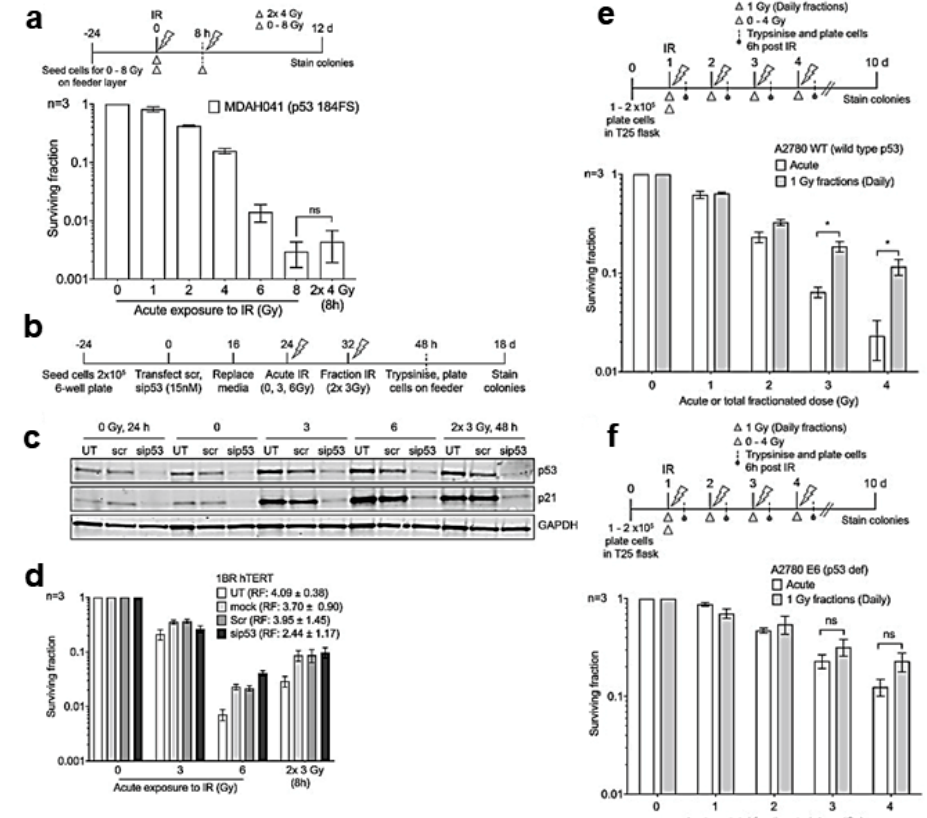
Figure 4. p53 modulates RT fraction size sensitivity in normal and malignant cells. ( a – d ). Split-dose recovery is not observed in primary fibroblast with loss of functional p53. ( a – d ). Transformed Li-Fraumeni fibroblasts MDAH041 were exposed to either acute or split-dose IR with indicated doses. ( a ) Colony survival assay confirms loss of split-dose recovery (white triangle, single acute dose, and gray triangle represents split dose IR). ( b ) Schema for ( c ) Western blot analysis showing the expression levels of total p53, p21, and loading control GAPDH and ( d ) colony survival of p53 siRNA knockdown in 1BR hTERT cells for the indicated period. UT is untreated, mock represents cells treated with DharmaFECT1 transfection reagent, and Scr is the ON-TARGETplus non-targeting control scramble. RF, the ratio of split-dose to single dose survival, has been compared for each experimental condition. ( e , f ). Split-dose recovery is lost in tumor cell lines with mutant p53. Colony survival of tumor cell lines A2780 WT ( e , f ) A2780 E6 after exposure to either acute or daily fractionated IR with indicated doses. Top panel in each histogram shows the experimental schema, white triangle represents single acute dose and gray triangle 1 Gy daily fractions. Post IR (6 h) cells were trypsinized and pooled with cells collected from media, plated, and allowed to form colonies. A significant increase in split-dose recovery is observed in p53 WT A2780 ( e ) but not in mut p53 A2780 E6 ( f ) (modified after [72] with